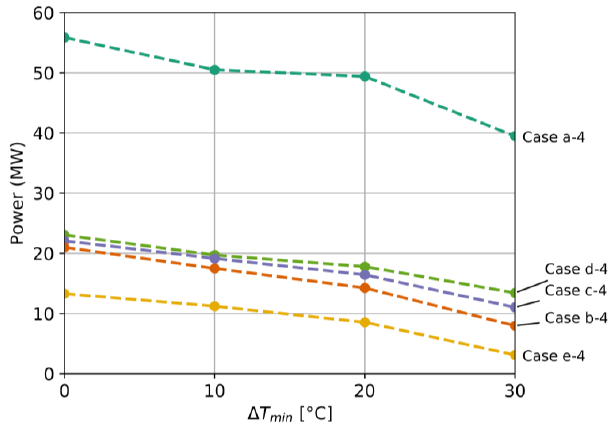
Figure 11. Cogeneration targets for the different cases and different values of ΔT min .